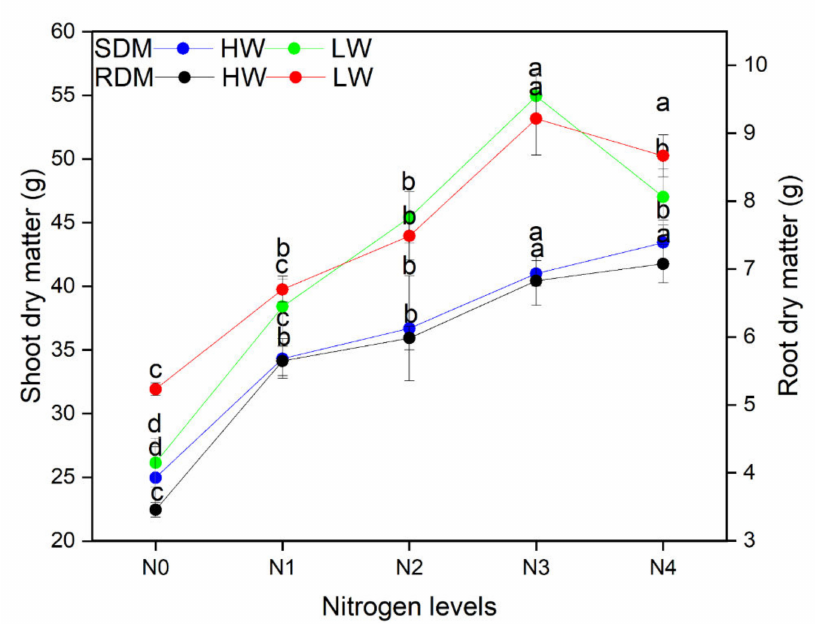
Figure 1. Effect of irrigation and nitrogen treatments on root and shoot dry matter. Means followed by different lowercase letters within each treatment indicate significant differences ( p < 0.05). Bars represents standard errors. The nitrogen treatments N0, N1, N2, N3 and N4 represent the application of nitrogen at the rates of 0, 200, 250, 300 and 350 kg ha − 1 . HW and LW represent irrigation water at the rate of 80 and 60% of field capacity. RDM and SDM are root and shoots dry matter,